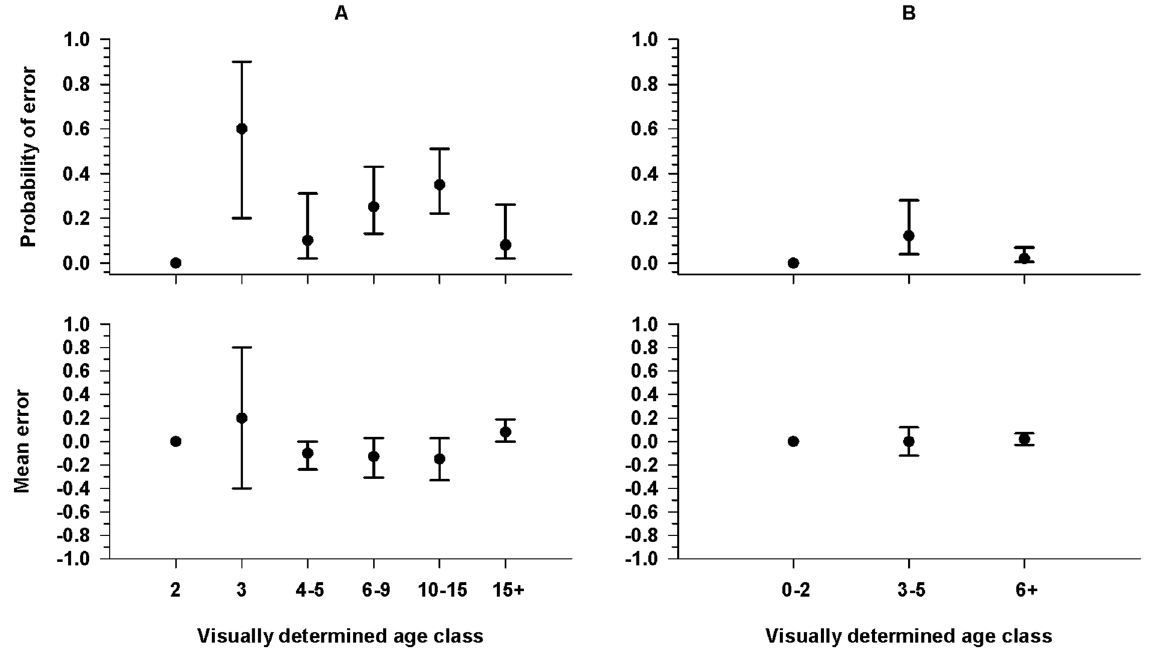
Figure 4. Probability of an error and mean size of the error in visual age classifications. Probability of error and mean size of error for the 8-category (A) and 3-category (B) visual-based age classifications relative to measurement-based classifications of Pacific walruses hauled out on the northwest coast of Alaska in fall of 2010 and 2011. Measurement-based age classifications are not possible for 0- and 1-yr classes, because tusks are not visible from walruses in these age classes. Error bars indicate 95% confidence intervals.